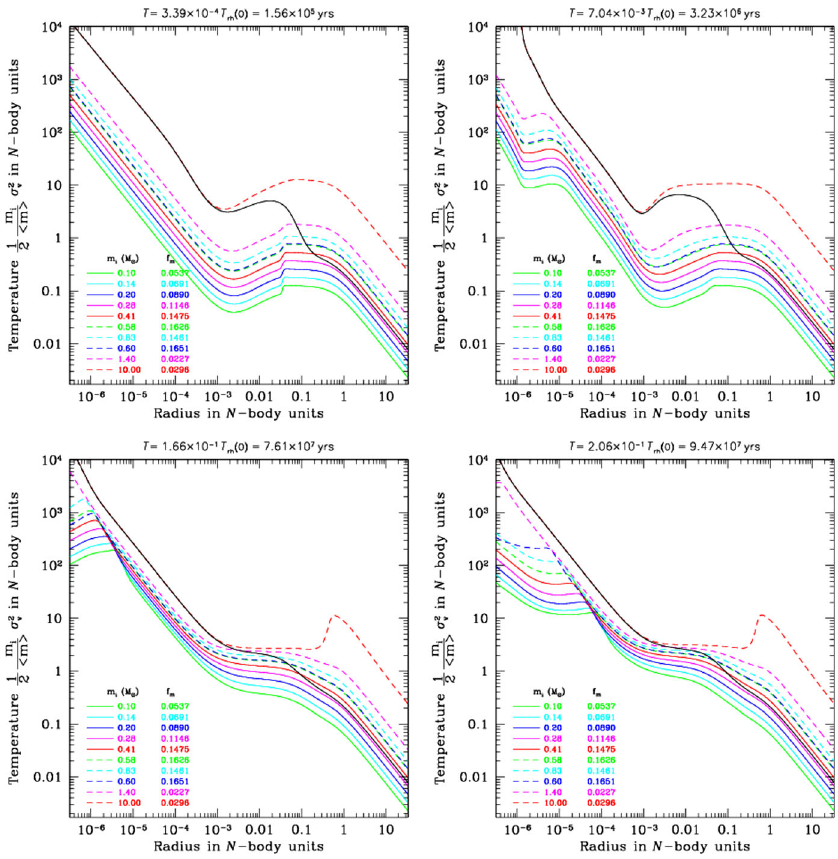
Fig. 38 Different moments in the evolution of the cluster temperature for a 10 stellar components system with a seed MBH